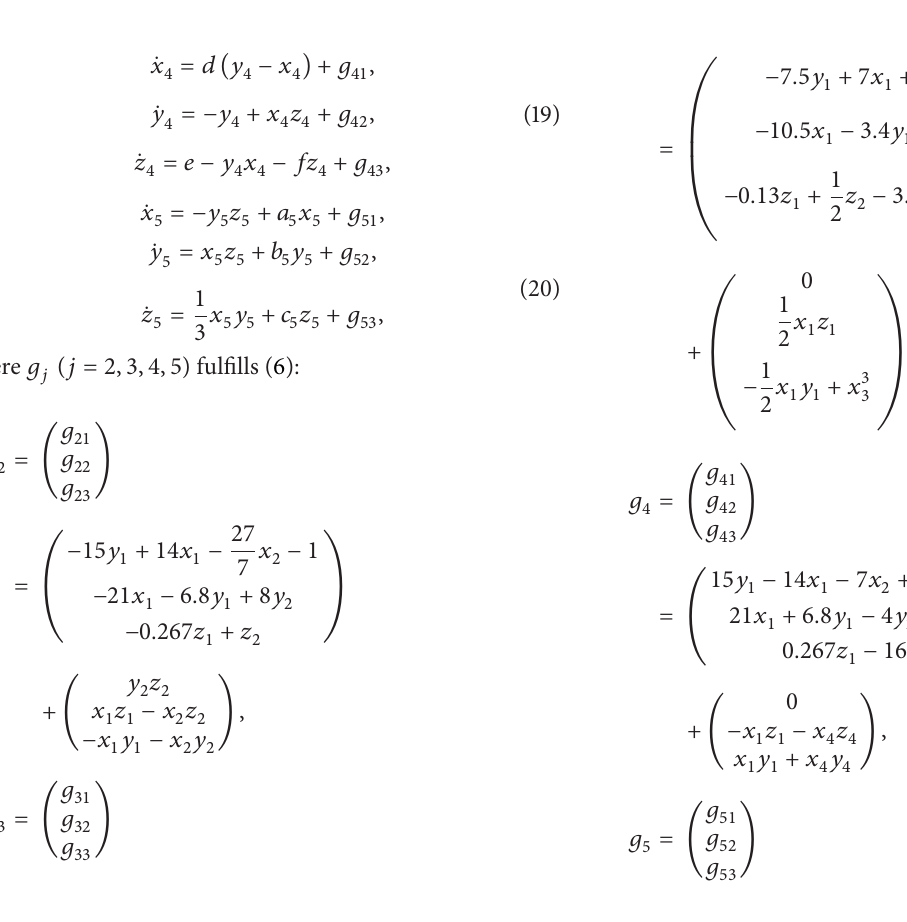
Figure 11: The temporal evolution of variables between node 2 (“ ⋅⋅⋅ ”) and node 3